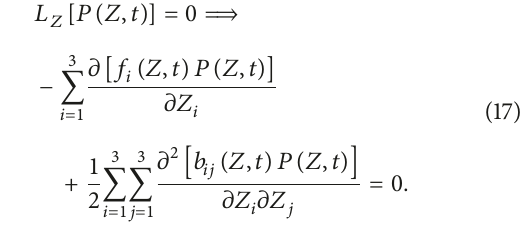
When 𝑡 󳨀→ ∞ , 𝑃(𝑍, 𝑡) is independent of time and satisfies reduced FPK